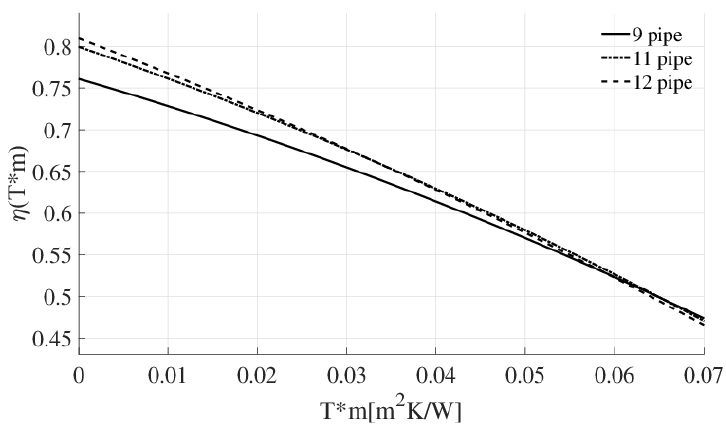
Figure 9. Experimental verification of the correlation between the changes in the thermal efficiency η ( T ∗ m ) and the number of working pipes in the solar